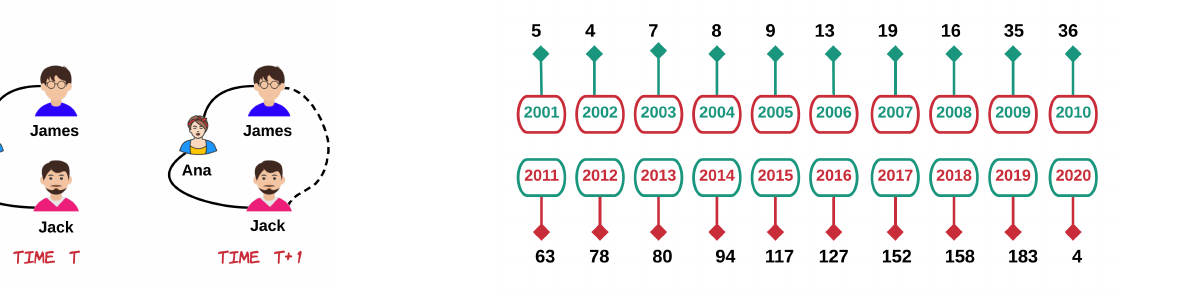
Figure 1. Example of Link Prediction in Social Network Figure 2. Yearly Publications on the topic of Link Prediction